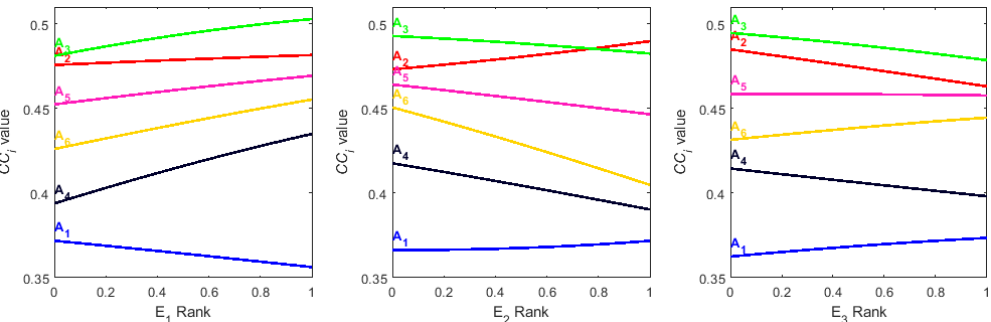
Figure 8. Closeness coefficient values depending on the rank of experts ( 𝛽 = 1 ).